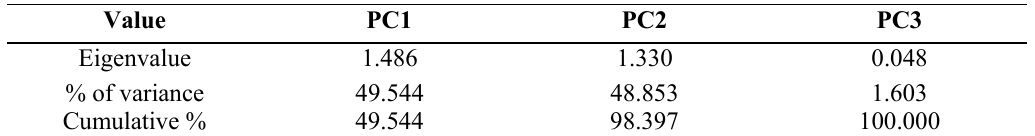
Table 5. Explained variance and eigenvalues (PC1: first principal component, PC2: second principal component, PC3: third principal component).